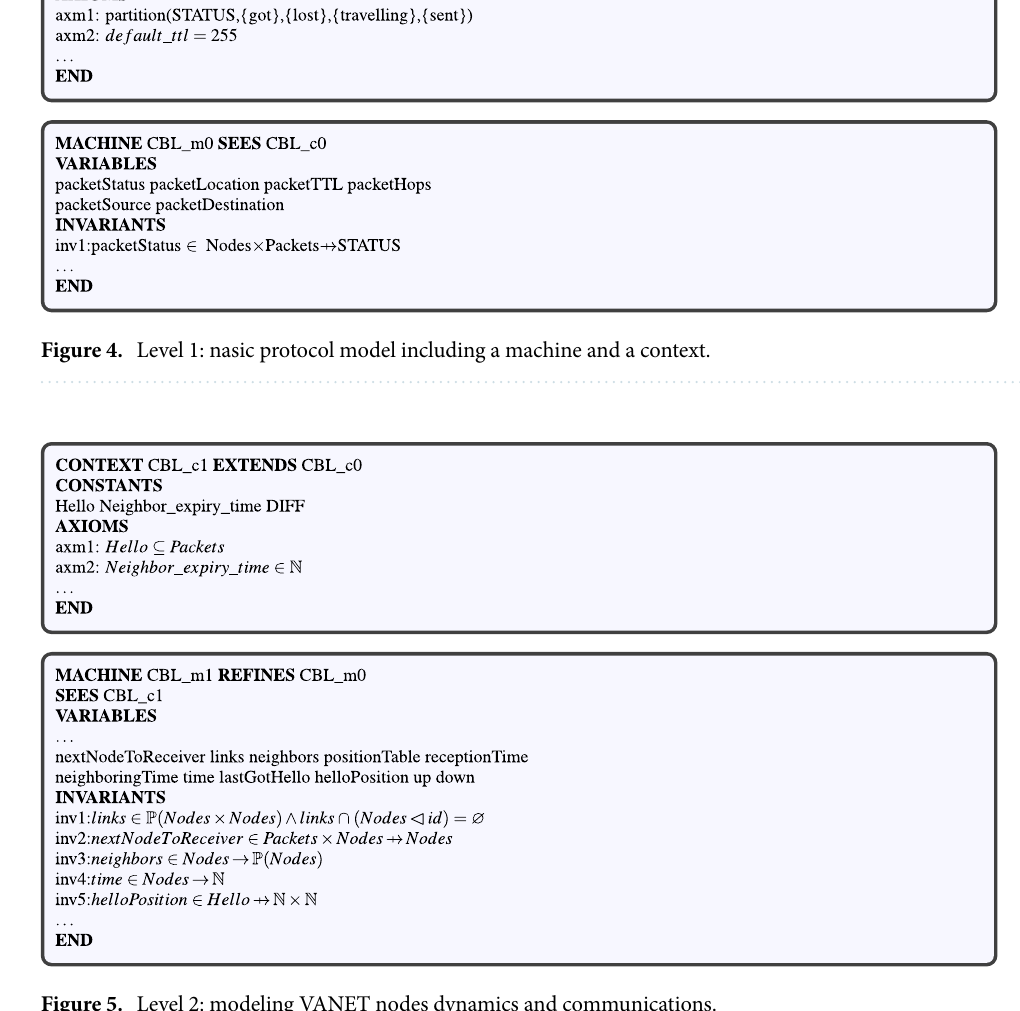
Figure 5. Level 2: modeling VANET nodes dynamics and